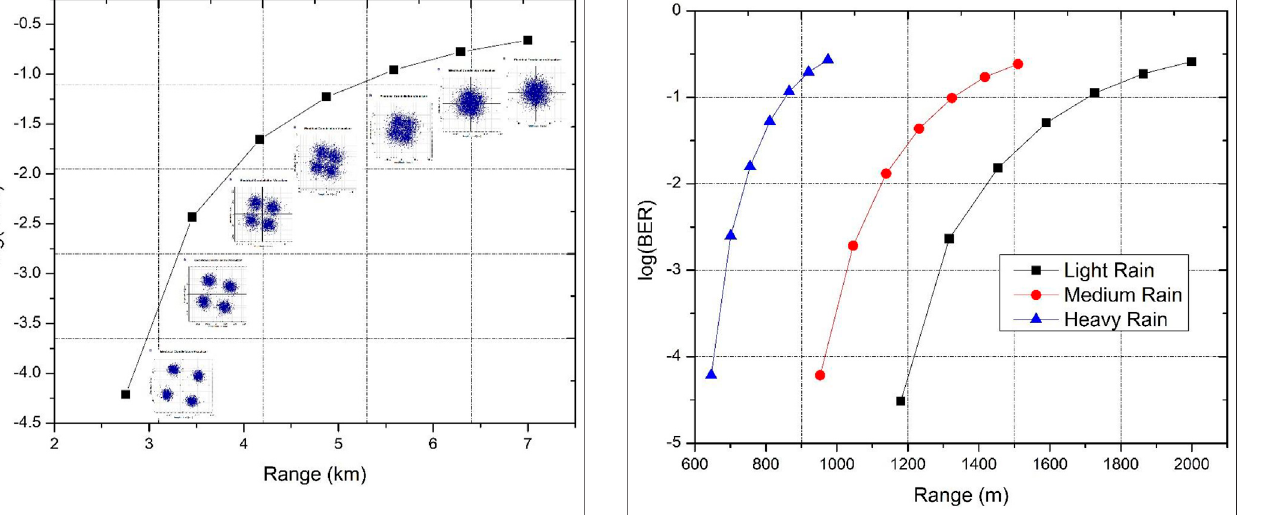
Frontiers in Physics |